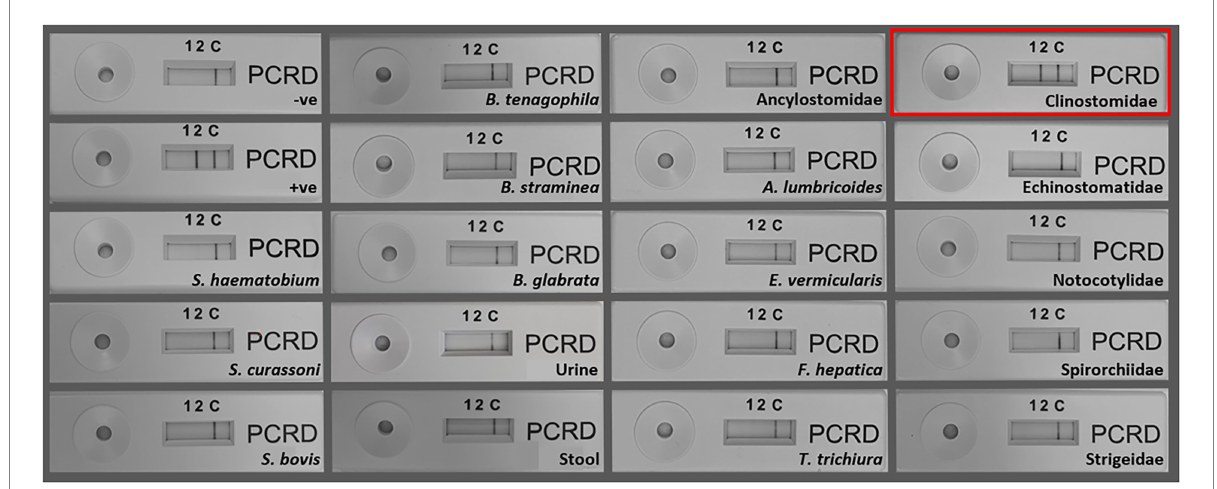
FIGURE 6 Specificity of the SmMIT-LF-RPA. The assay was specific to Schistosoma mansoni with no cross-reactivity with S . haematobium, S . bovis, S . curassoni , human stool, human urine B . glabrata, B . straminea, B . tenagophila , A . lumbricoides, Ancylostomidae, E . vermicularis, T . trichiura, F . hepatica , and trematodes belonging to the families, Echinostomatidae, Notocotylidae, Spirorchiidae, and Strigeidae. Cross-reactivity was observed for a Clinostomidae trematode (highlighted in red). Legend: +ve-positive control (1 ng of S . mansoni gDNA); − ve-negative control